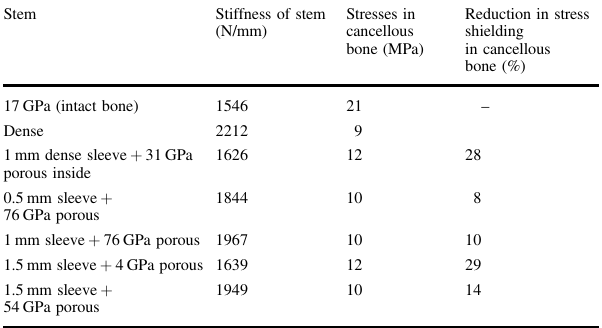
Table 3 Stress shielding in cancellous bone under walking load